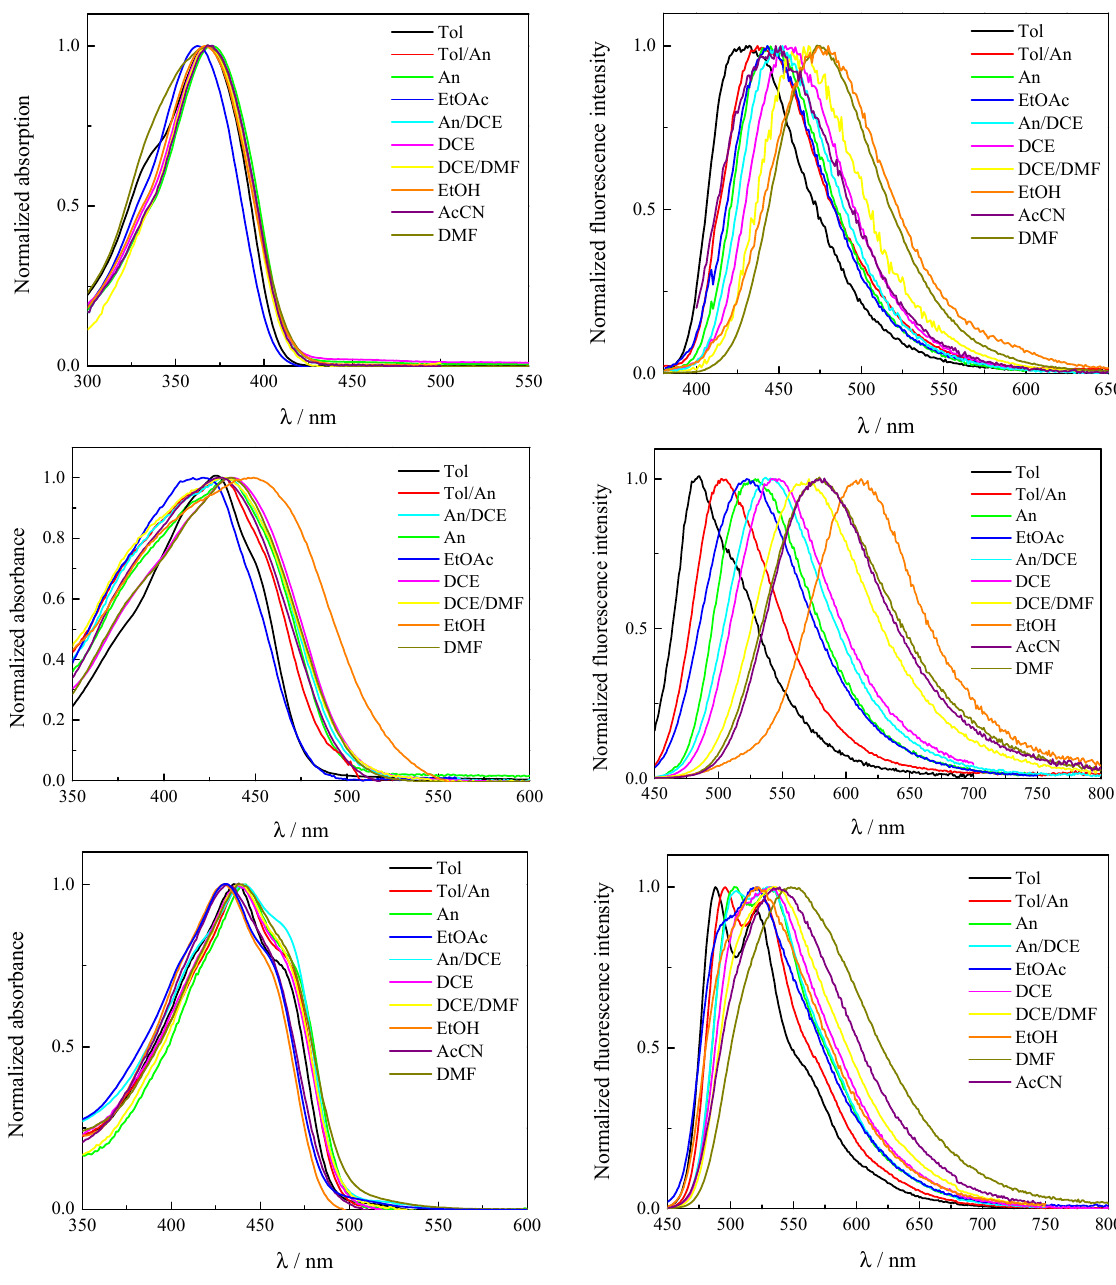
Figure 1. Absorption and emission spectra of compounds DMA-QP ( top ), DMA-QF ( middle ), and DMA-QT ( bottom ) in solvents of different polarity and polarizability. (Tol—toluene; An—anisole; EtOAc—ethyl acetate; DCE—1,2-dichloroethane; DMF—dimethylformamide; EtOH—ethanol; AcCN—acetonitrile).